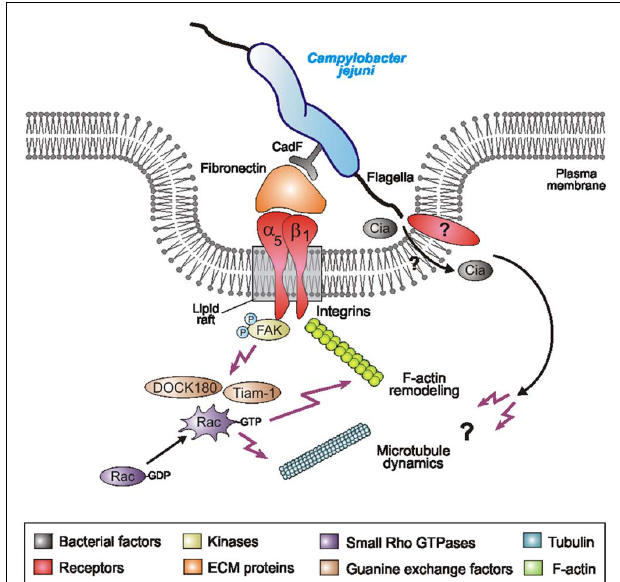
FIGURE 9 | Proposed model for C. jejuni -induced signaling leading to Rac1 activation and bacterial invasion. C. jejuni adheres to host cells via the fibronectin-binding protein CadF which acts as a bridge engaging the integrin β 1 receptor. Integrin occupancy and clustering in lipid rafts leads to recruitment and activation of the non-receptor tyrosine kinase FAK. Phosphorylation of FAK triggers a cascade of signals resulting in the formation of protein complexes leading to activation of GEFs, including DOCK180 andTiam-1. Activated DOCK180 andTiam-1 then induce the activation of Rac1.This potentially causes localized actin and/or microtubule rearrangements at the site of C. jejuni entry, resulting in bacterial uptake. In addition to C. jejuni cadF , some flagellar genes also appear to play a role. If the flagellum participates by sole bacterial motility, by translocating bacterial Cia effector proteins or targeting a host receptor directly is not yet